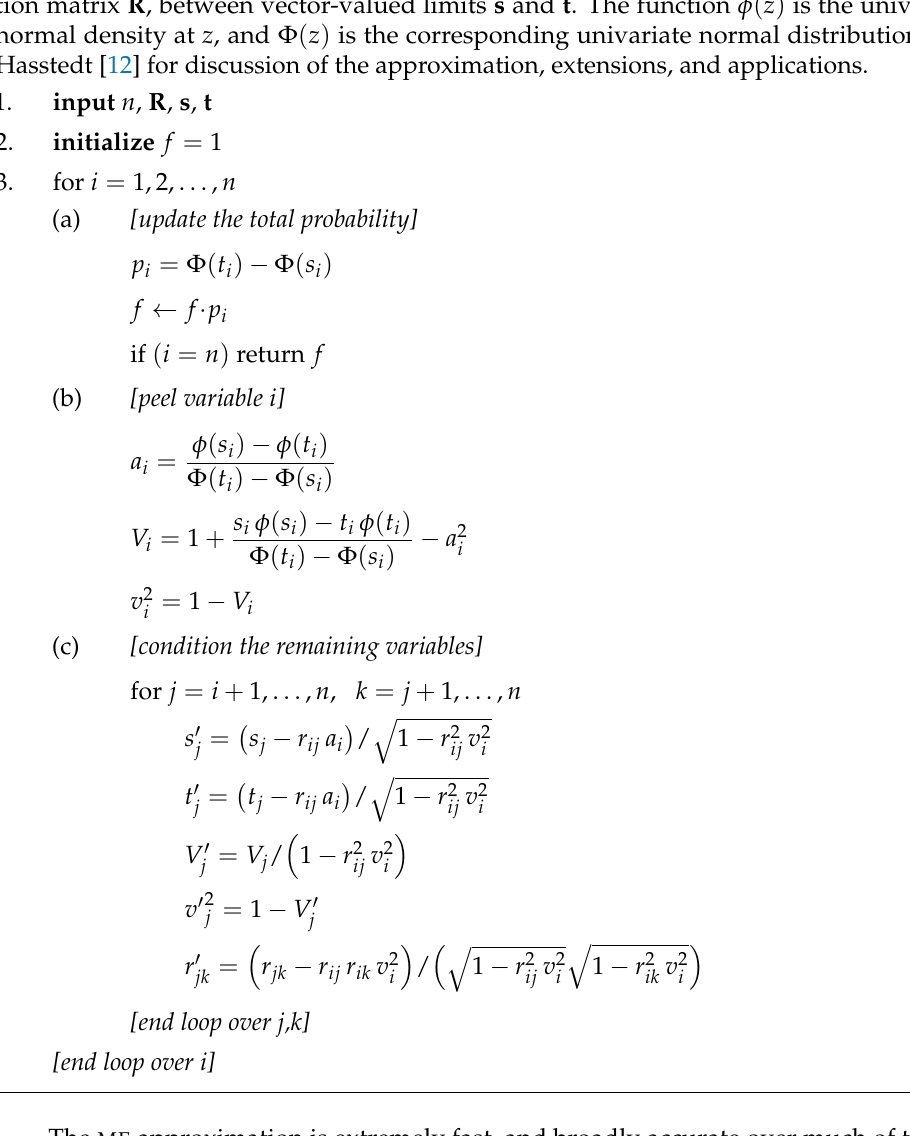
Algorithm 1 Mendell-Elston Estimation of the MVN Distribution